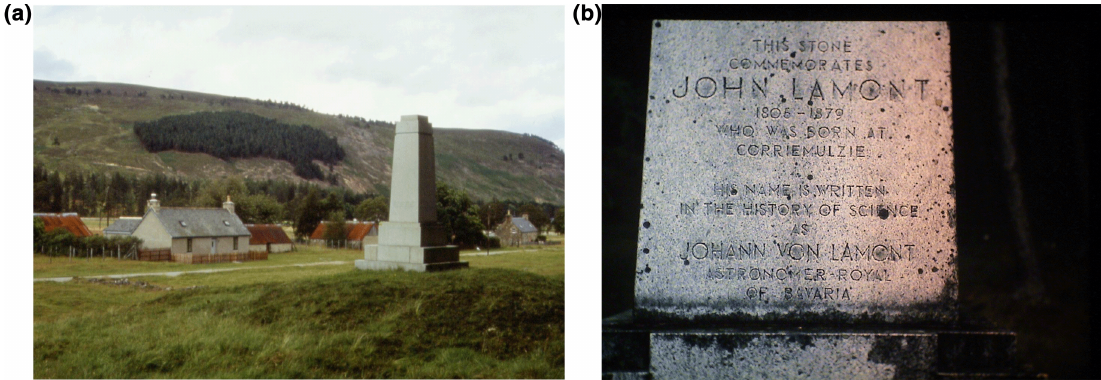
Figure 8. (a) Monument for Lamont in front of his old school building in Invery. (b) Inscription on the monument: “This stone commemorates John Lamont, 1805–1879, who was born at Corriemulzie. His name is written in the history of science as Johann von Lamont, Astronomer Royal of Bavaria”.